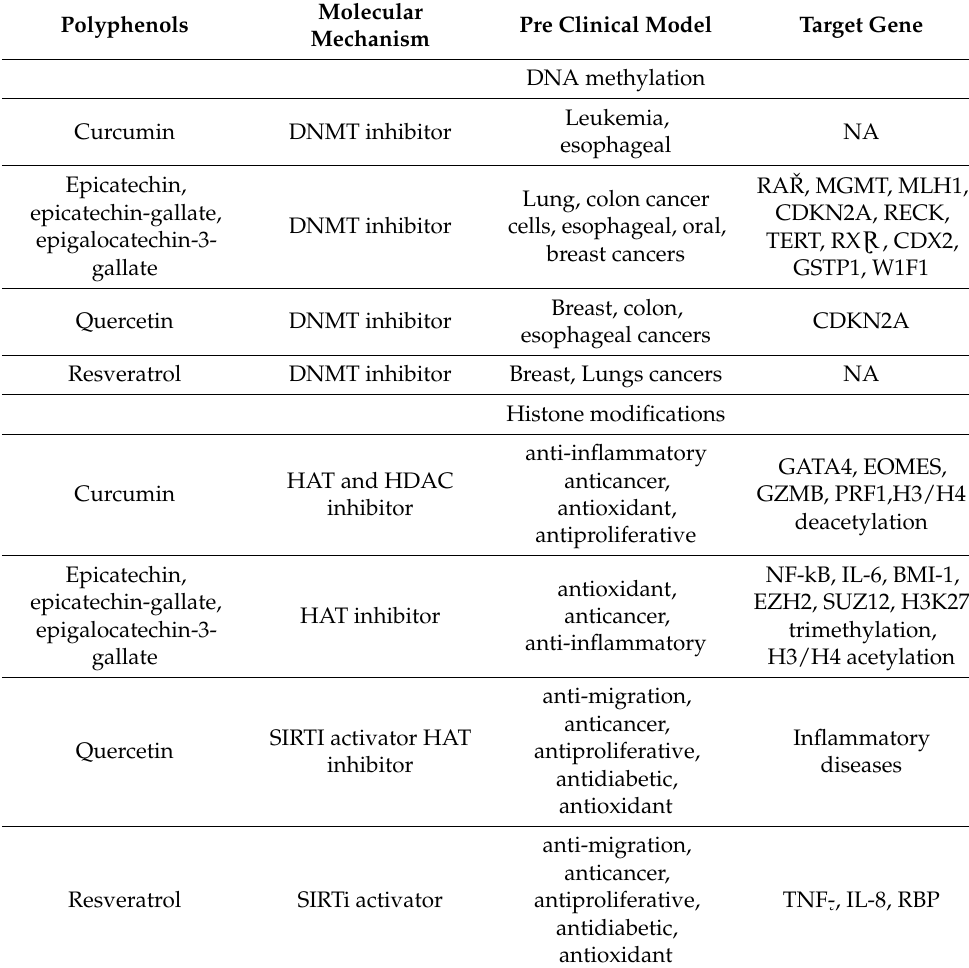
Table 1. Polyphenols on DNA methylation and histone modification.